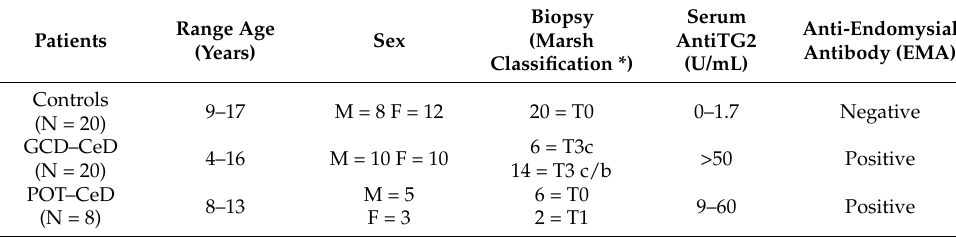
Table 1. Patients’ characteristics.